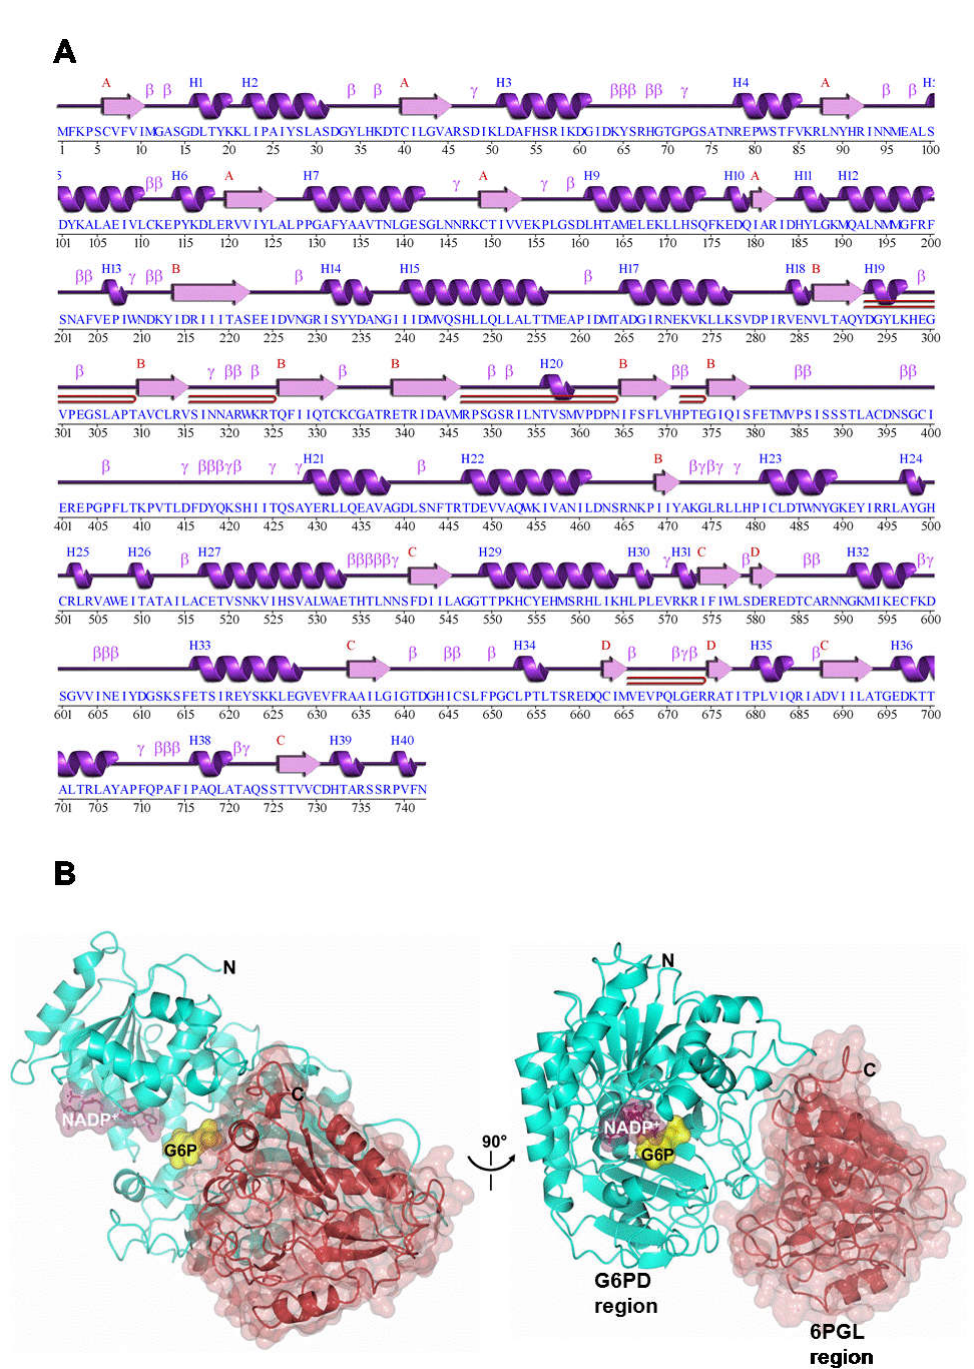
Figure 10. A predicted and annotated secondary structure motif and homology model of the full-length G6PD::6PGL protein from G. lamblia G6PD. ( A ) Secondary structure elements are shown as α-helices and β-sheets. The numbers indicate the corresponding amino acid residues. ( B ) The three-dimensional structure in two views related by a vertical rotation of 90 degrees showing the N-terminal G6PD enzyme (residues 1–515, cyan) and the C-terminal 6PGL enzyme (residues 516–742, pale crimson).